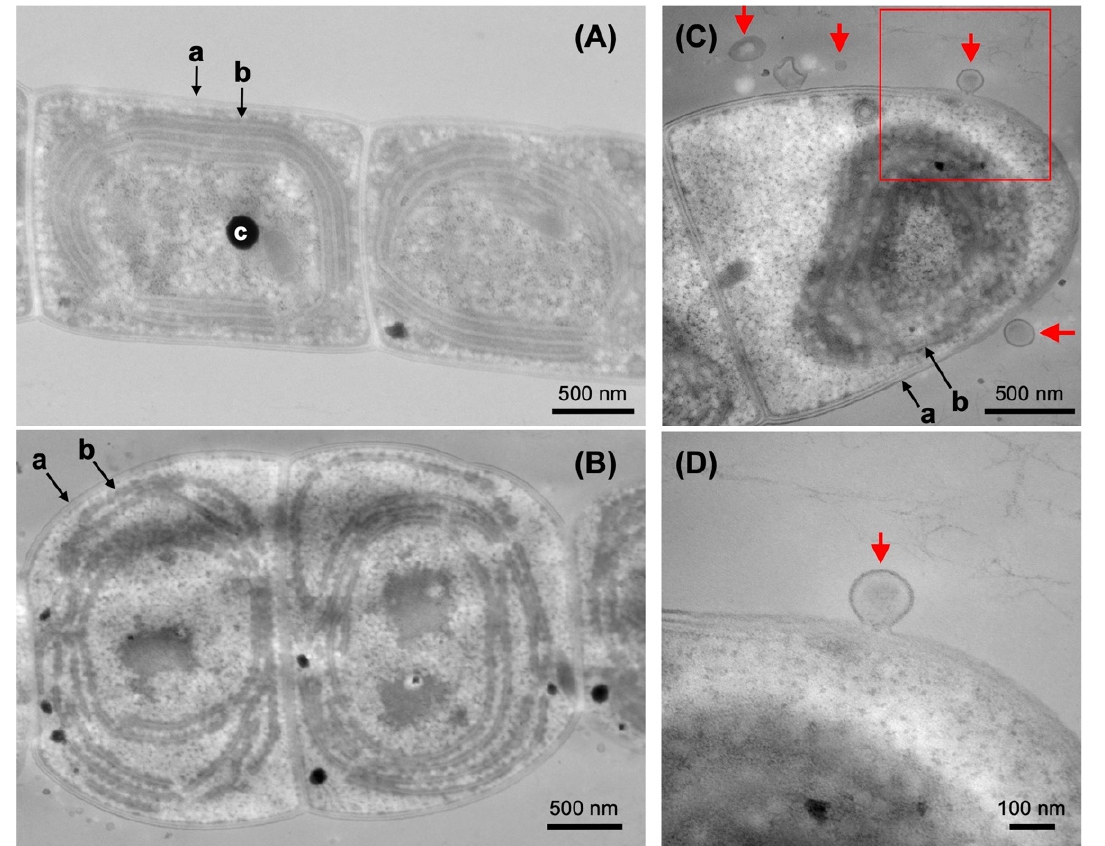
Figure 7. TEM observation of dg5 (wild type) ( A ) and YFC2 ( B – D ) cells grown in the dark. Photo ( D ) is enlarged images of photo ( C ) (red square). EV-like structures are indicated by red arrows. a, outer membrane; b, thylakoid membrane; c, lipid granule.